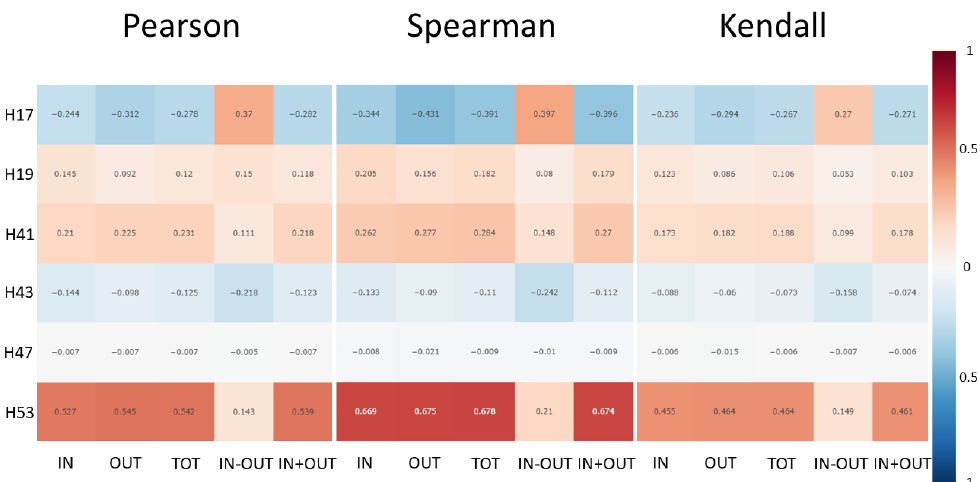
Figure 1. Correlation heat map of weight (W) and 5 types of traffic (T) on the x-axis for hives H17, H19, H41, H43, H47, and H53 on the y-axis; IN—incoming traffic; OUT—outgoing traffic; TOT—total traffic; IN-OUT—difference of IN and OUT; IN+OUT—sum of IN and OUT; TOT = IN + OUT + LAT (sum of IN, OUT, and LAT), where LAT—lateral traffic; IN, OUT, LAT, and TOT are non-negative